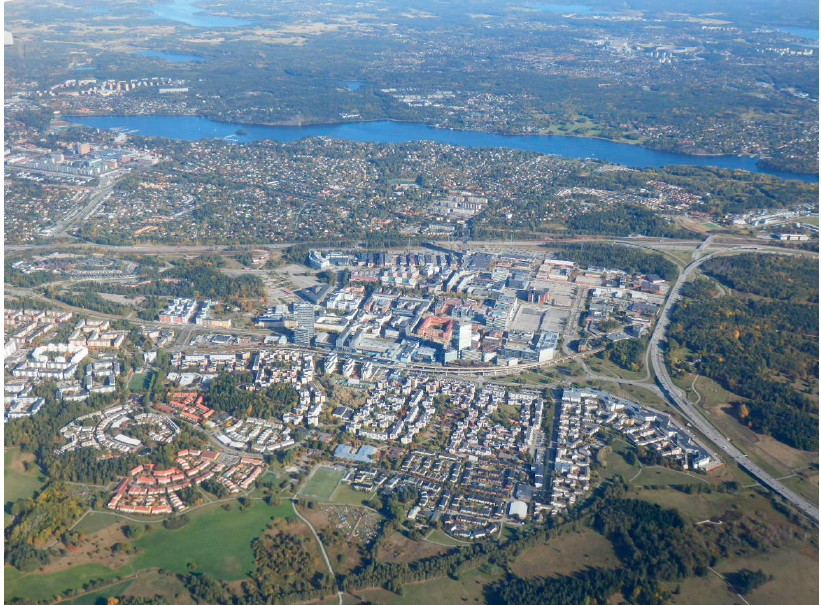
Figure 25. Kista satellite town in the Stockholm region showing dense, mixed, walkable, and transit-